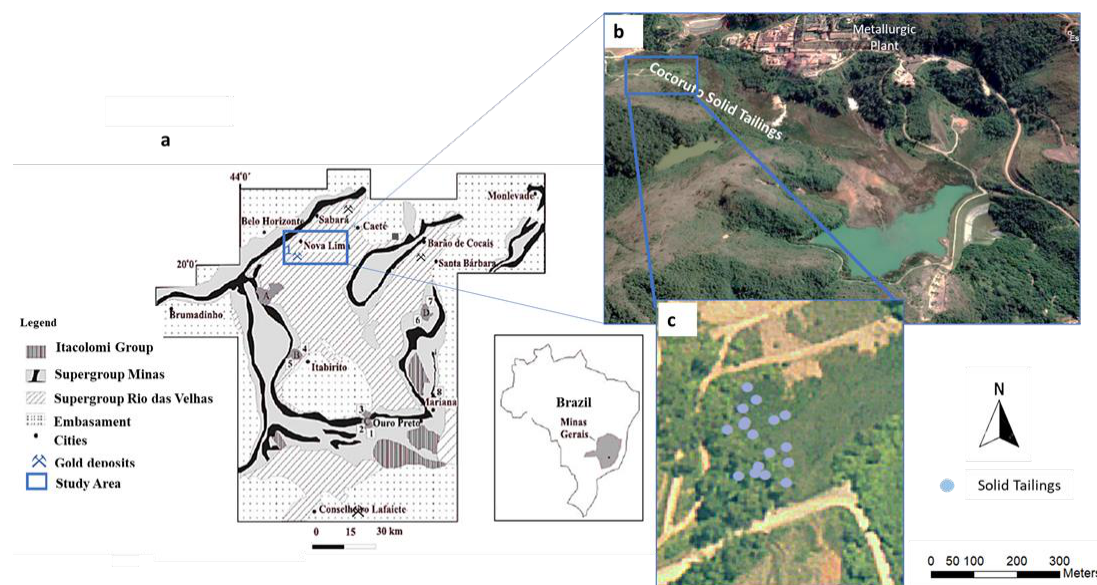
Figure 1. Location of the study area and Iron Quadrangle map ( a ) [43,44]; ( b , c ) Images of the Cocoruto Dam sampled area (SIRGAS2000—10-09-2019).